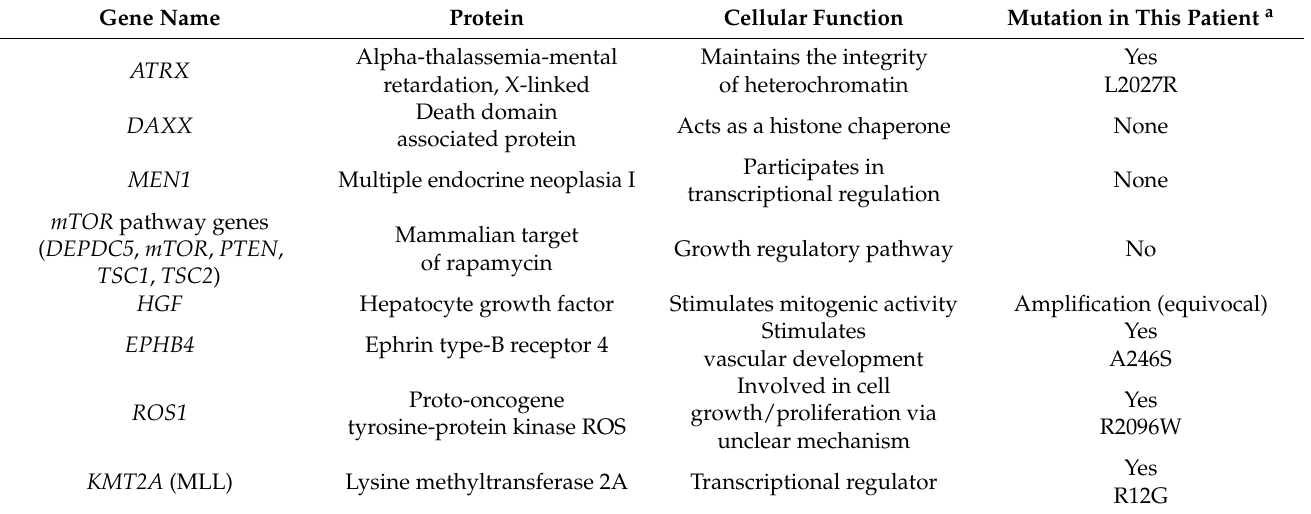
Table 2. Molecular Profiling of Liver